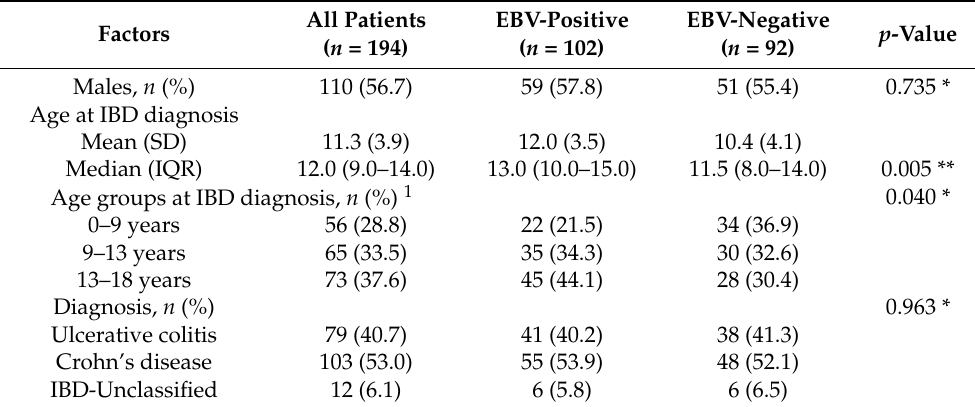
Table 2. Univariate logistic regression model for factors associated with positive EBV serology in 194 patients with EBV status available at IBD diagnosis.